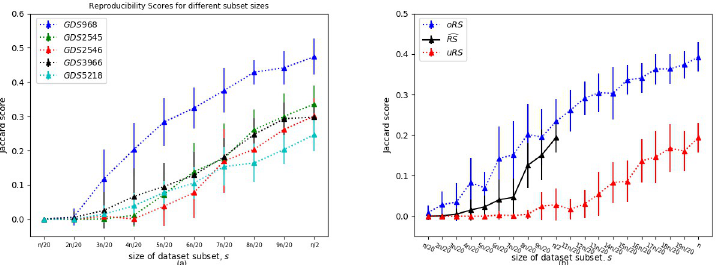
Fig 4. Reproducibility Scores for different subset sizes. (a) For each of the 5 datasets D , each point shows the average how the approximations relate to one another, and scale with the size s of the dataset. Here we are using subsets of the Metabric dataset, with n = 1654. We observed the same behavior for all datasets.